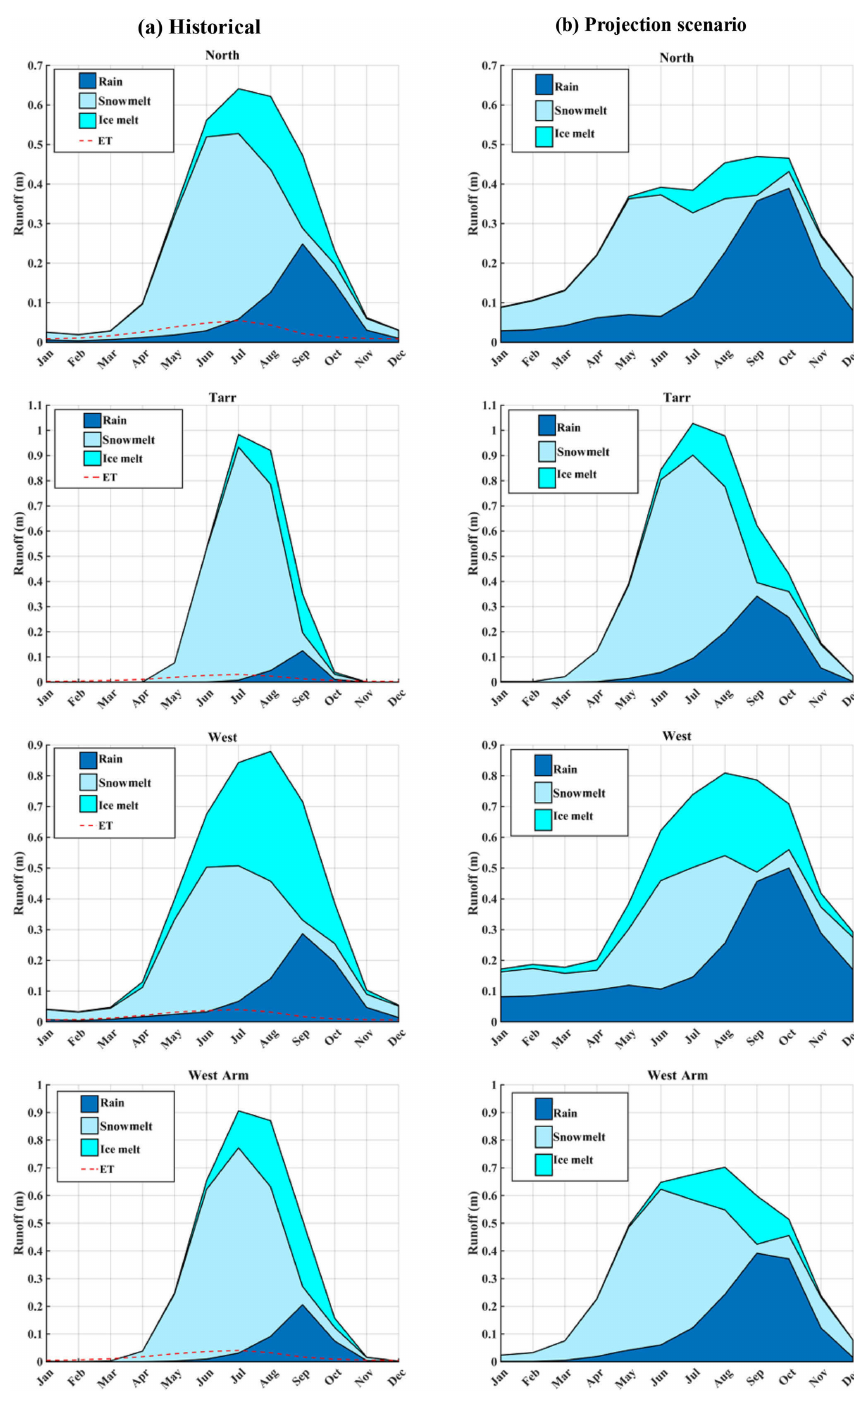
Figure B1. (a) The historical runoff climatologies by watershed, partitioned into the constituents of snowmelt, ice melt, and rain runoff. The historical MODIS-based evapotranspiration estimates are included on the historical plots, but the amounts are not subtracted from the modeled for runoff climatology because they were derived separately from the modeling process. (b) The projection scenario runoff climatologies by